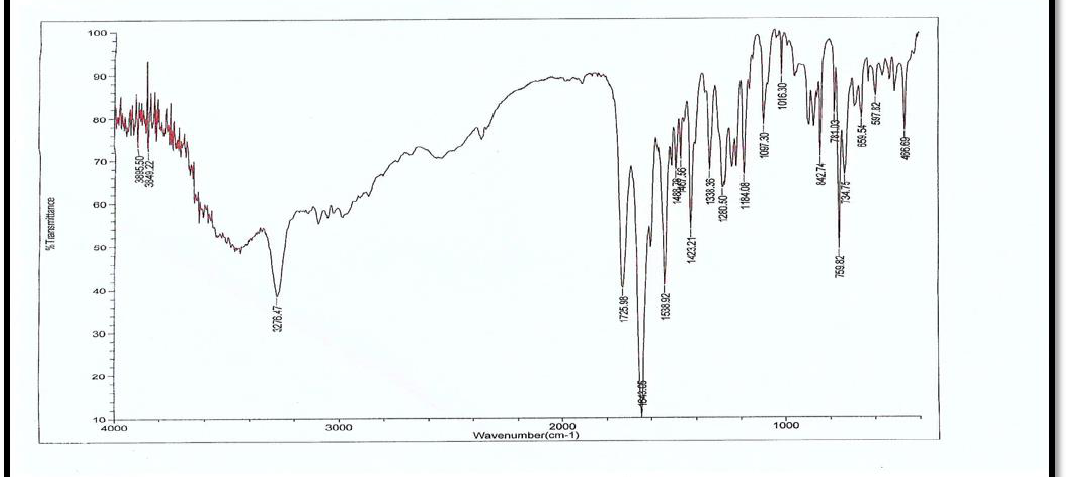
Figure 8. FTIR spectrum of REM The FTIR spectrum of selected formula (SD30) was shown in Figure (9). It was examined and matched with those of FTIR of REM and TPGS spectrum